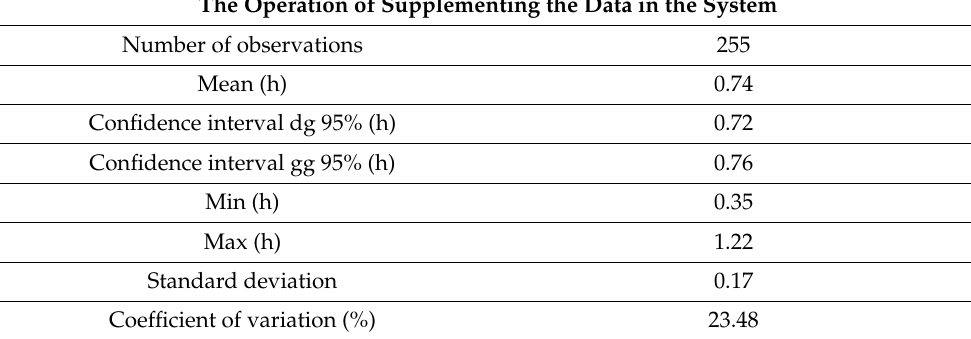
Table 3. Basic statistics on the time of the execution of operation b 1